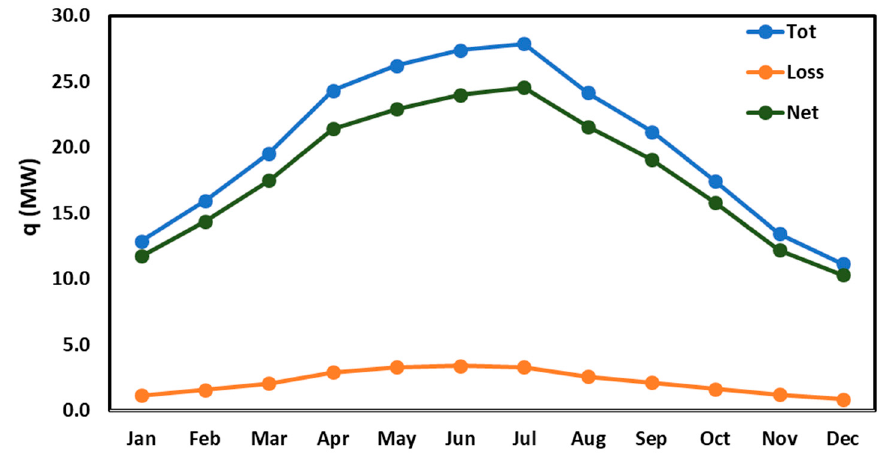
Figure 7. Monthly average absorbed heat rate by the solar receiver, heat loss, and net heat gain in di ff erent months of a